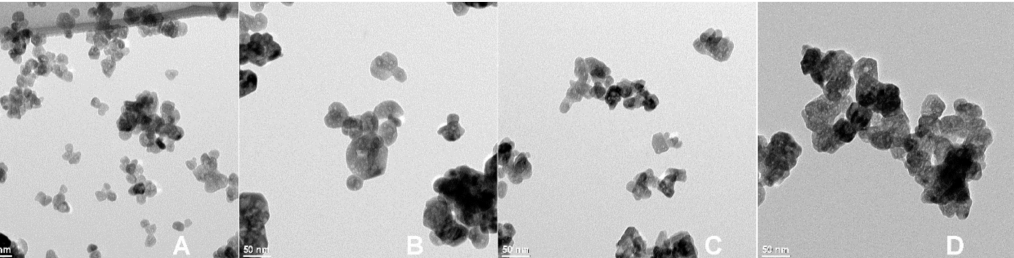
Figure 3. TEM images of ZnO nanoparticles prepared from [Zn(acetate) 2 (amine) x ] precur- sors in a water/methanol mixture with rapid NaOH addition at 65 ◦ C. Average particle size is given for each material. The precursors used were ( A ) [Zn(acetate) 2 (Tris) 2 ] (20 ± 4 nm),